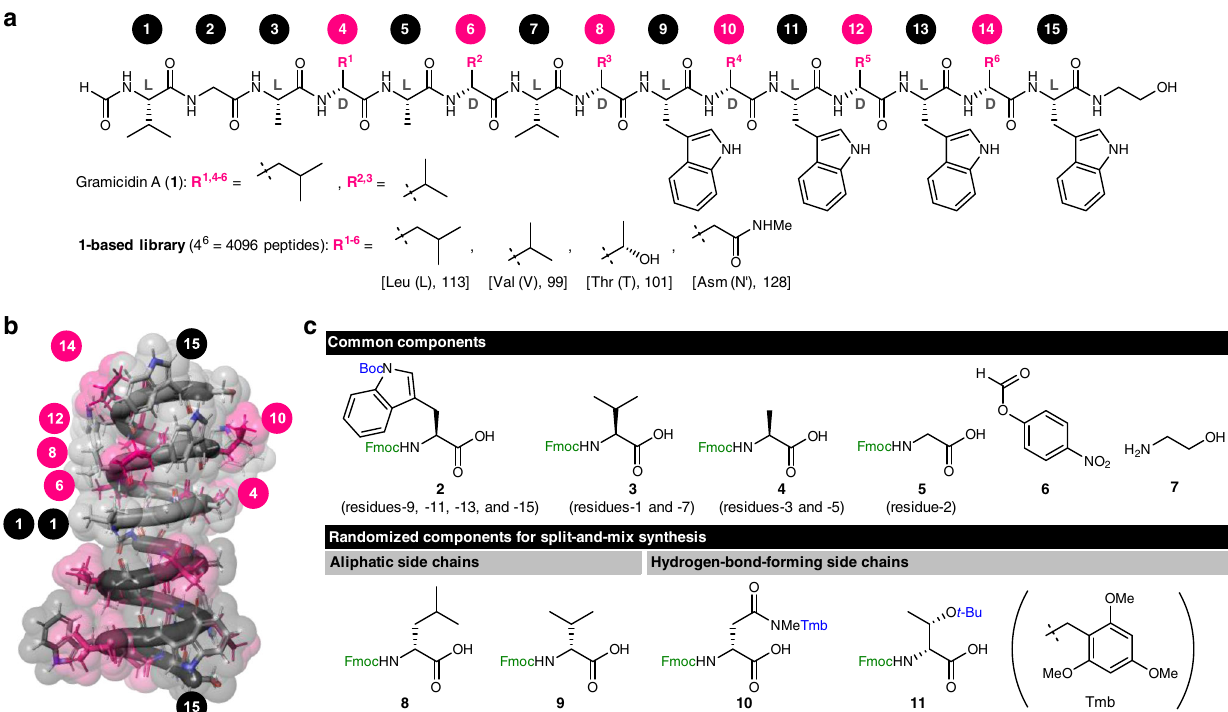
Fig. 1 Structures of compounds used in this study. a Structures of gramicidin A ( 1 ) and prepared analogues. Both the three-letter and one-letter codes of the amino acids, and molecular weights of the residues, are displayed in brackets. D -Asm (N ′ ) D - N γ -methylaspargine. b A three-dimensional structure of the head-to-head dimer of the β 6.3 -helix of 1 (PDB ID: 1MAG). The substituted aliphatic residues are highlighted in pink. c Synthetic component amino acids of the 1 -based OBOC library. Boc tert -butoxycarbonyl, Fmoc 9- fl uorenylmethoxycarbonyl, t -Bu tert -butyl, Tmb